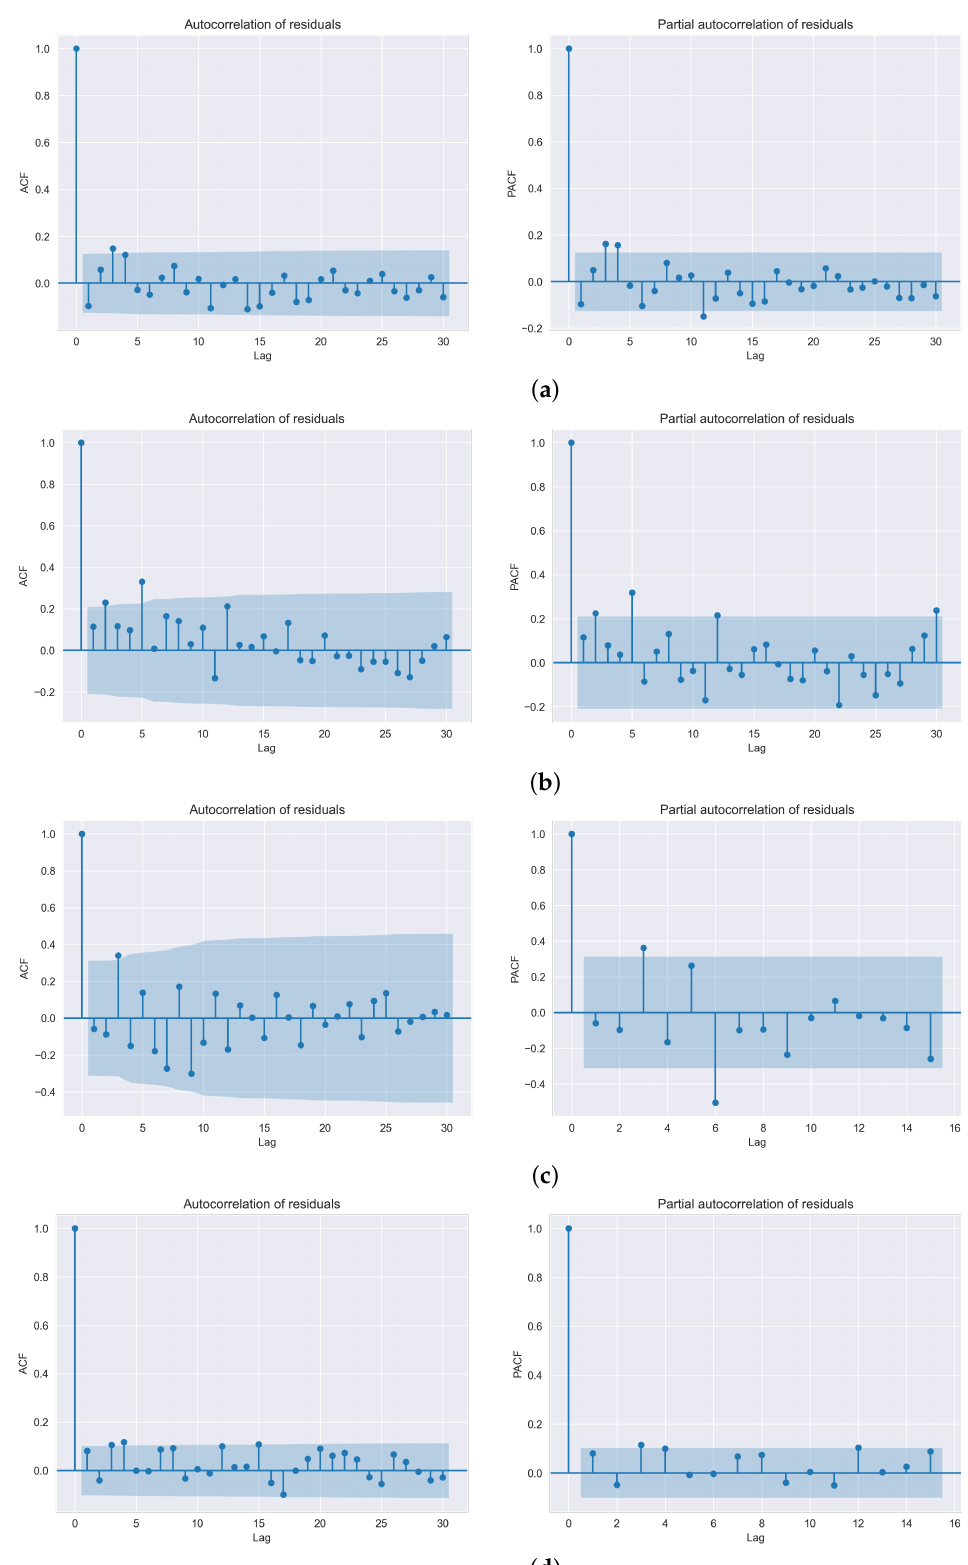
Figure A5. ACF and PACF plots for the residuals of VR models (special case: HH = 28) in each